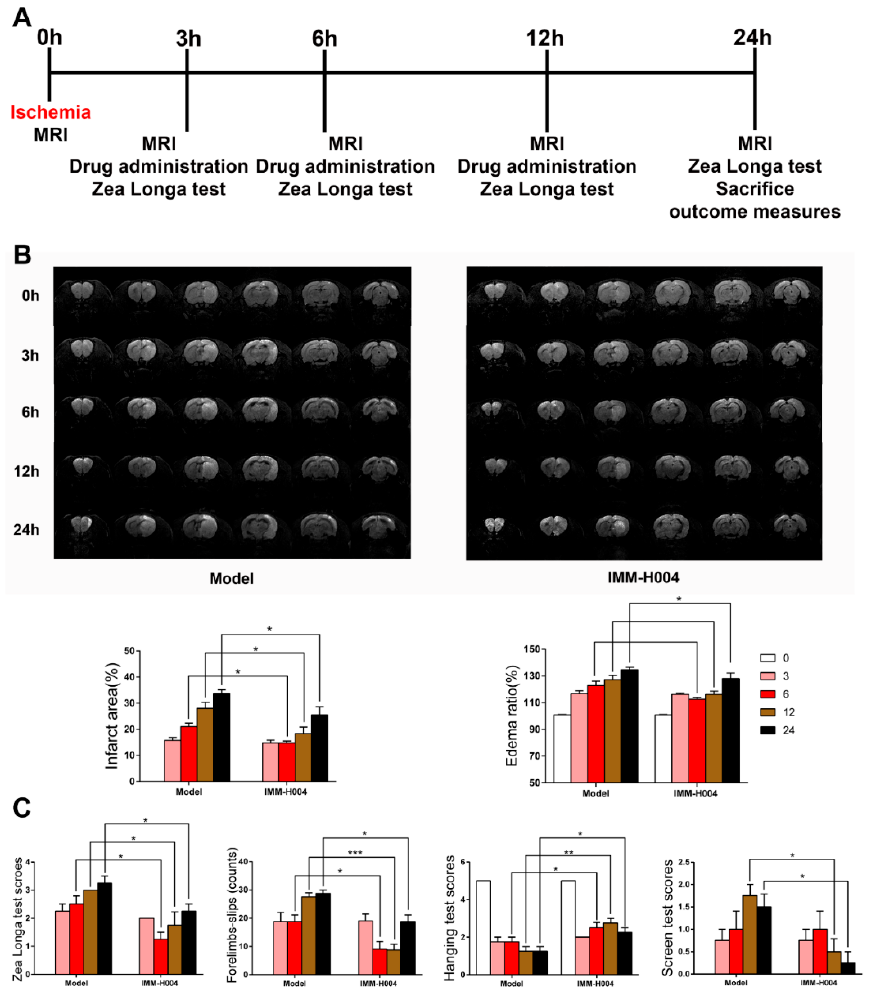
Figure 4. Successive administration of IMM-H004 3 times a day for one day protects against Permanent focal cerebral ischemia-induced brain injury in adult rats. ( A ) The timeline diagram of successive administration of IMM-H004 3 times a day for one day. ( B ) Representative coronal DWI images, and analysis of infarction area and edema ratio. ( C ) Statistical analysis of the Zea Longa test scores, Forelimbs-slips, Hanging test scores, and screen test scores. Data are shown as the mean ± SD ( n = 10/group). * p < 0.05 vs. model; ** p < 0.01 vs. model; *** p < 0.001 vs. model.